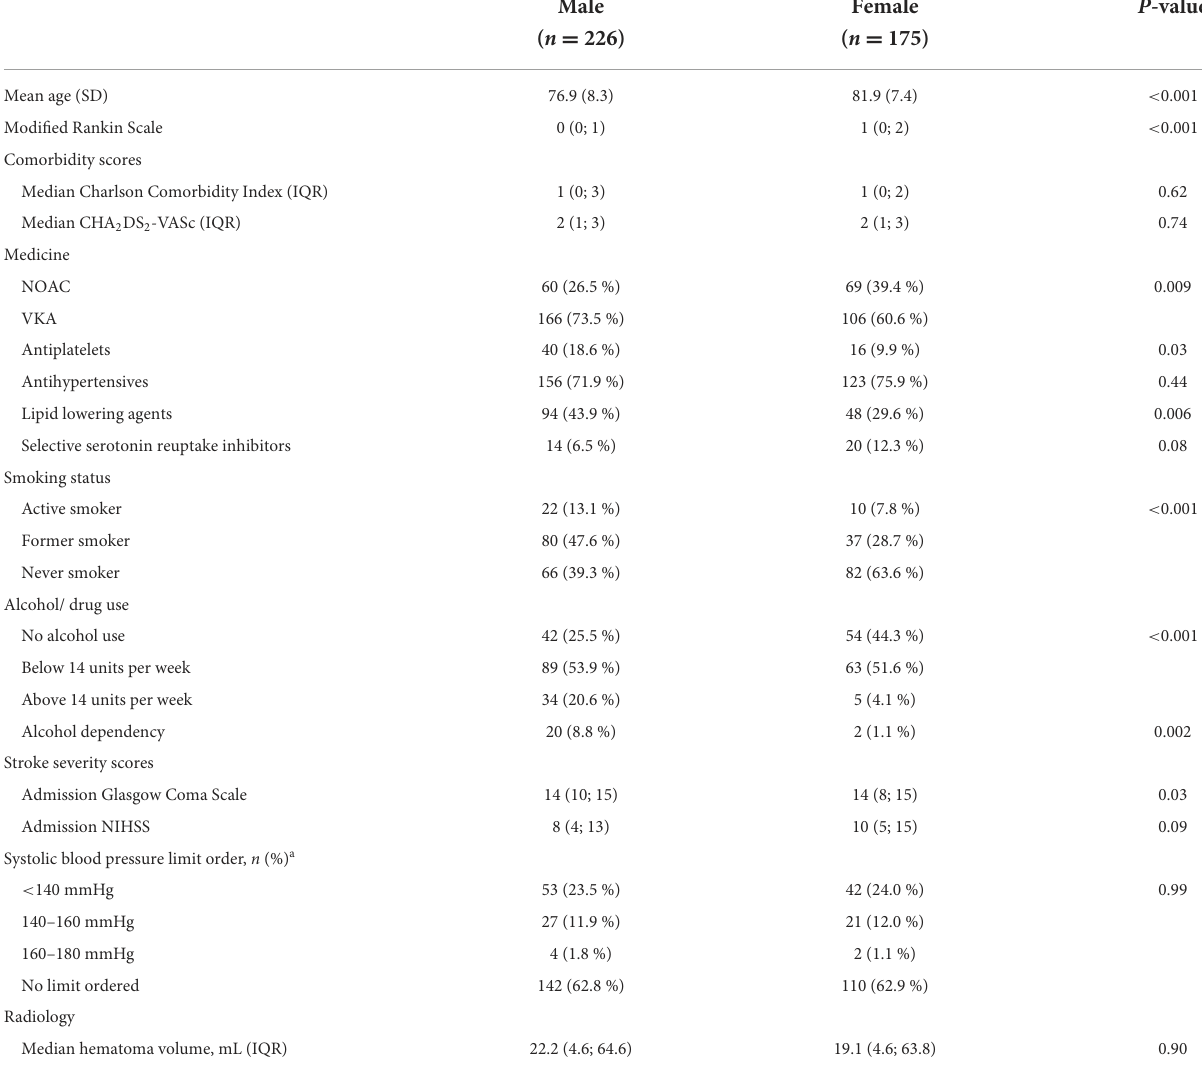
TABLE 1 Baseline data in 401 men and women with oral anticoagulant (OAC)-related intracerebral hemorrhage